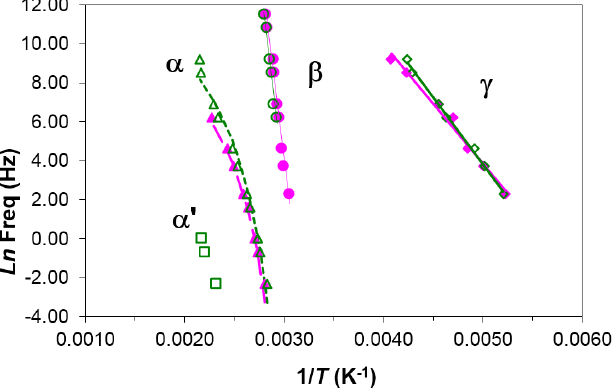
Figure 8. Relaxation map for PEI2000-PLA20 at different heating rates: 0.5 °C/min (open symbols) and 2 °C/min (filled symbols).